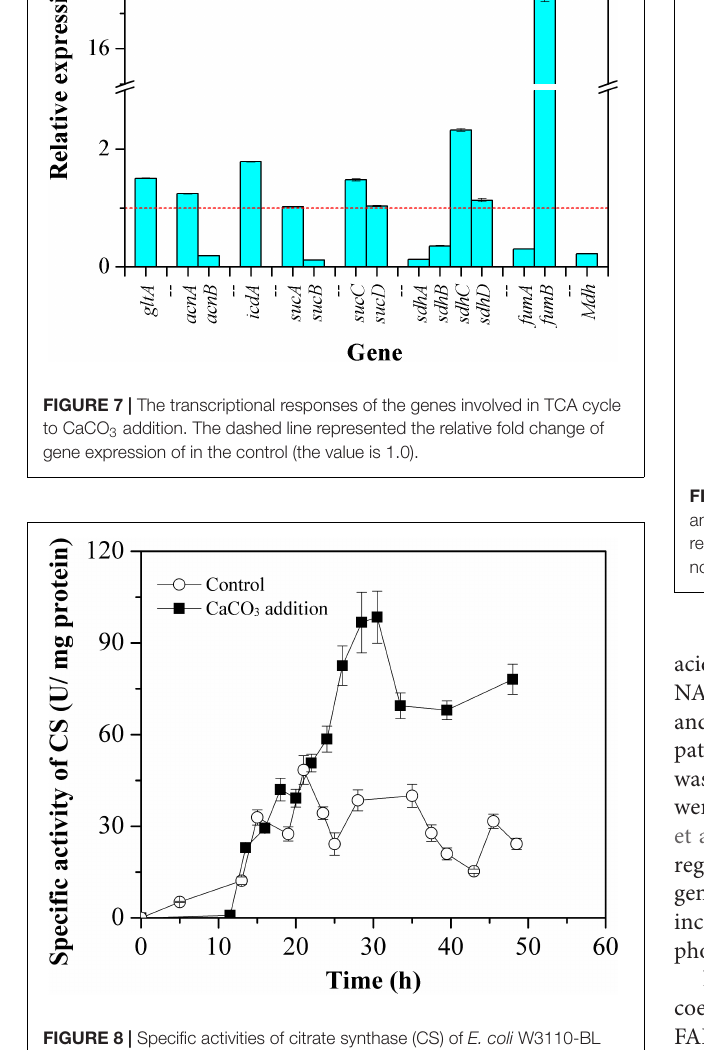
FIGURE 8 | Specific activities of citrate synthase (CS) of E. coli W3110-BL during growth in the batch cultivation with or without CaCO 3 addition. The CS activity was measured in crude cell extracts and all measurements were performed in triplicate.